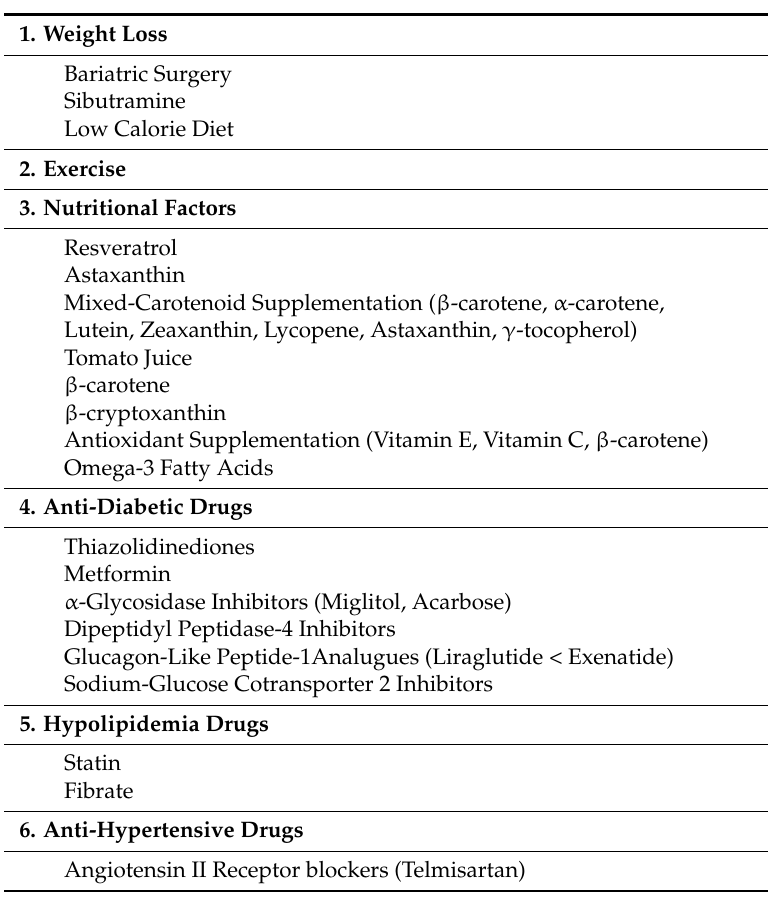
Table 1. Possible factors which increase circulating adiponectin